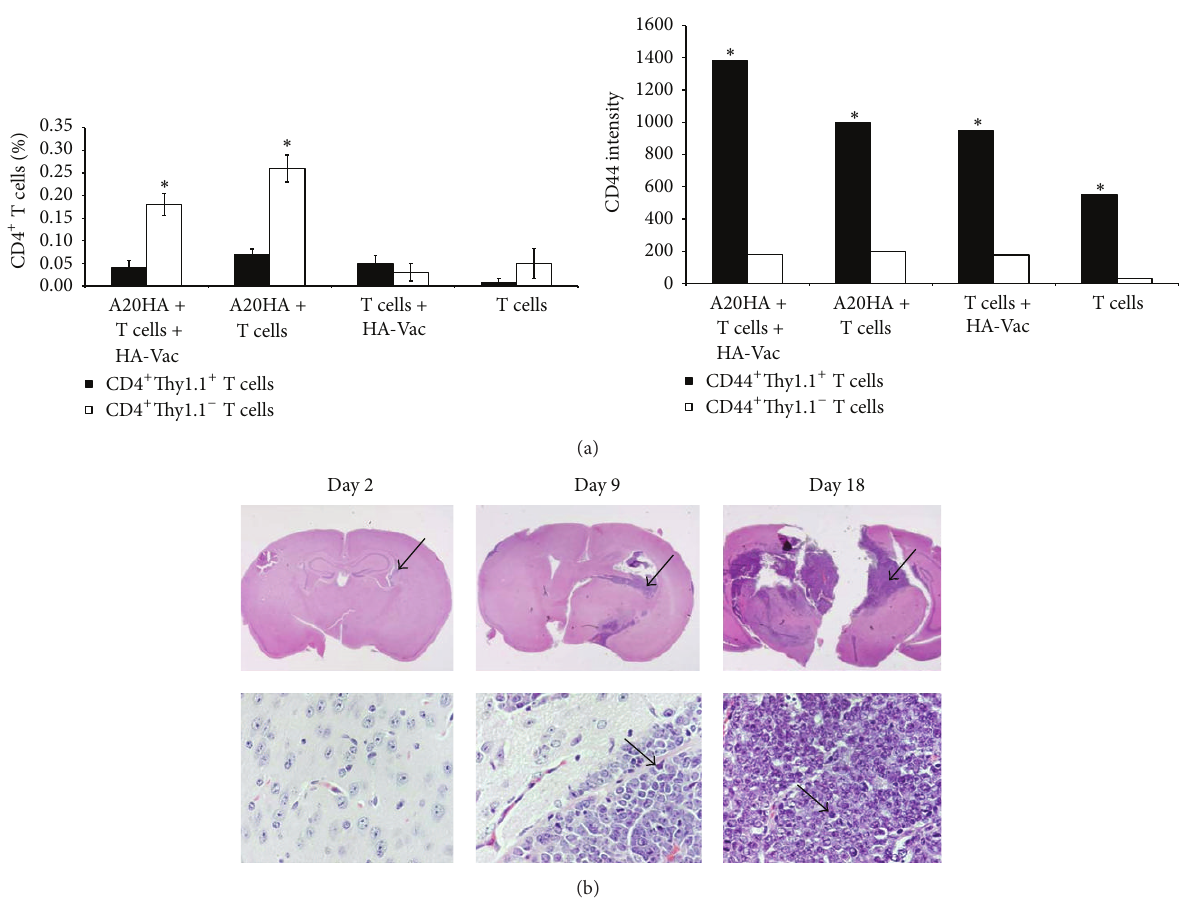
Figure 8: HA-specific activation stimulates migration of CD4 + T cells into the brain of A20HA brain tumor-bearing mice. (a) Percent (left bars) and CD44 intensity (right bars) of transgenic CD4 + Thy1.1 + T cells and nontransgenic CD4 + Thy1.1 − T cells from brains of A20HA brain tumor-bearing mice and A20HA tumor-free mice measured by FACS on day 18 after the adoptive transfer and HA vaccination. HA-specific CD4 + Thy1.1 + T cells were injected i.v. on day 5 after A20HA i.c. inoculation, and virus HA-Vac was delivered i.p. at the same day. Brain pools of three mice in each group were analyzed by FACS 18 days later. A20HA + T cells + HA-Vac, mice that received A20HA tumor cells, HA-specific CD4 + Thy1.1 + T cells, and HA-Vac; A20HA + T cells, mice that received A20HA tumor cells and HA-specific CD4 + Thy1.1 + T cells; T cells + HA-Vac, mice that received HA-specific CD4 + Thy1.1 + T cells and HA-Vac; T cells, mice that received only HA-specific CD4 + Thy1.1 + T cells. (b) Photomicrographs of eosin and hematoxylin stained coronal sections of the brains on days 2, 9, and 18 after the adoptive transfer showing growth dynamics of A20HA B-cell lymphoma in BALB/c mice that received HA-specific CD4 + T cells and HA-Vac on day 5 after A20HA i.c. inoculation. Magnifications × 1 (upper row; arrows show the tumor areas) and × 40 (lower row, arrows show single lymphocytes in the tumor areas). ∗ 𝑃 < 0.05